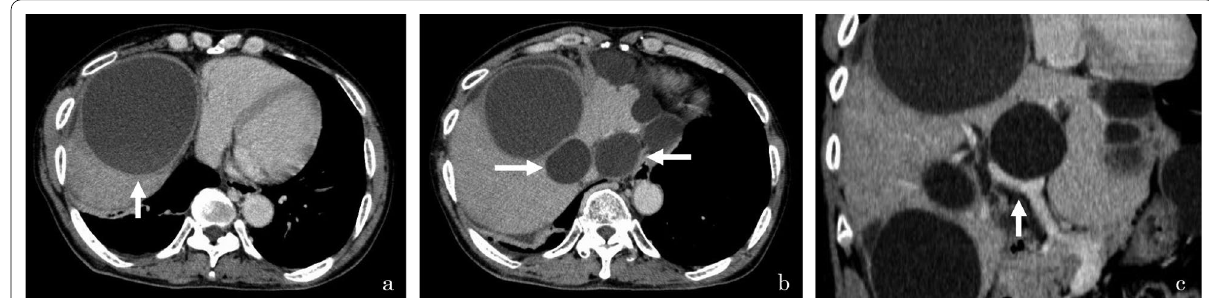
Fig. 1 Computed tomography (CT) image taken at the first visit. The cyst is observed in the eighth segment of the liver and measures 13 cm in diameter; it is the largest of the cysts in this case. The cyst appears to have compressed the right side of the heart and the right thoracic cavity ( a ). The cysts are observed to be located dorsal to the liver on both sides of the inferior vena cava (IVC); they were thought to have caused the stenosis of the IVC ( b ). One of the cysts is seen to be in contact with the right and left branches of the portal vein; the right branch appears compressed and stenotic ( c )